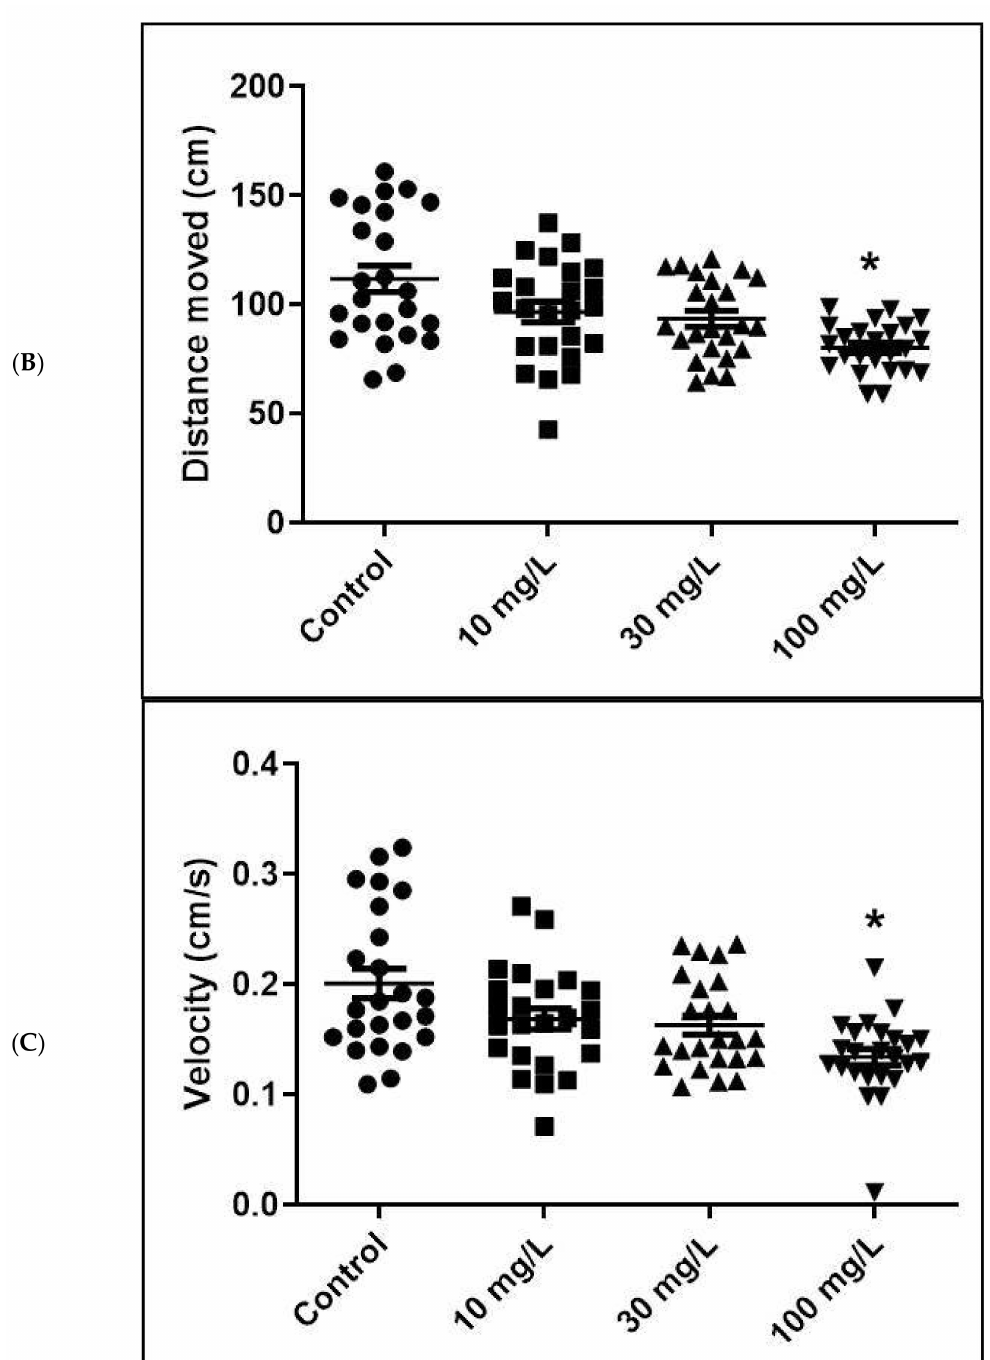
Figure 2. Behavioral effects following a 5-day exposure to acrylamide. ( A ). Acrylamide-treated wild-type zebrafish larvae exhibited impaired locomotor activity (circular movement and decreased swimming speed and distance traveled) that was concentration-dependent. ( B ). Distance traveled. ( C ). Swimming speed. * p < 0.01. Error bars represent the standard error of the